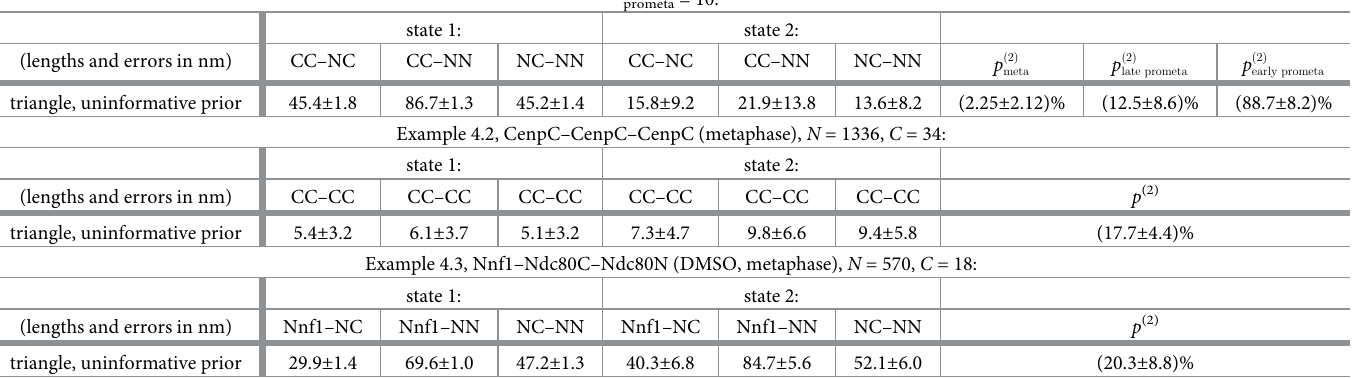
Table 4. Two-state experimental examples. Example 4.1, CenpC–Ndc80C–Ndc80N (DMSO, prometaphase-metaphase), N meta = 570, C meta = 17, N late prometa = 134, C late prometa = 4, N early prometa = 302, C early